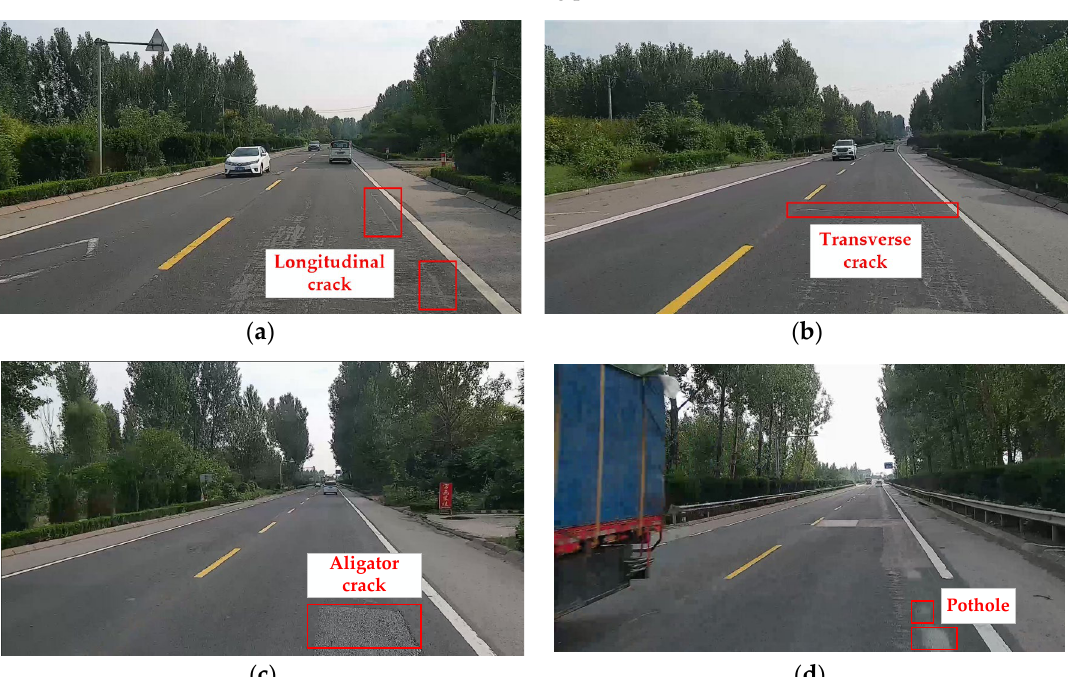
Figure 2. The locations for collecting pavement cracks.